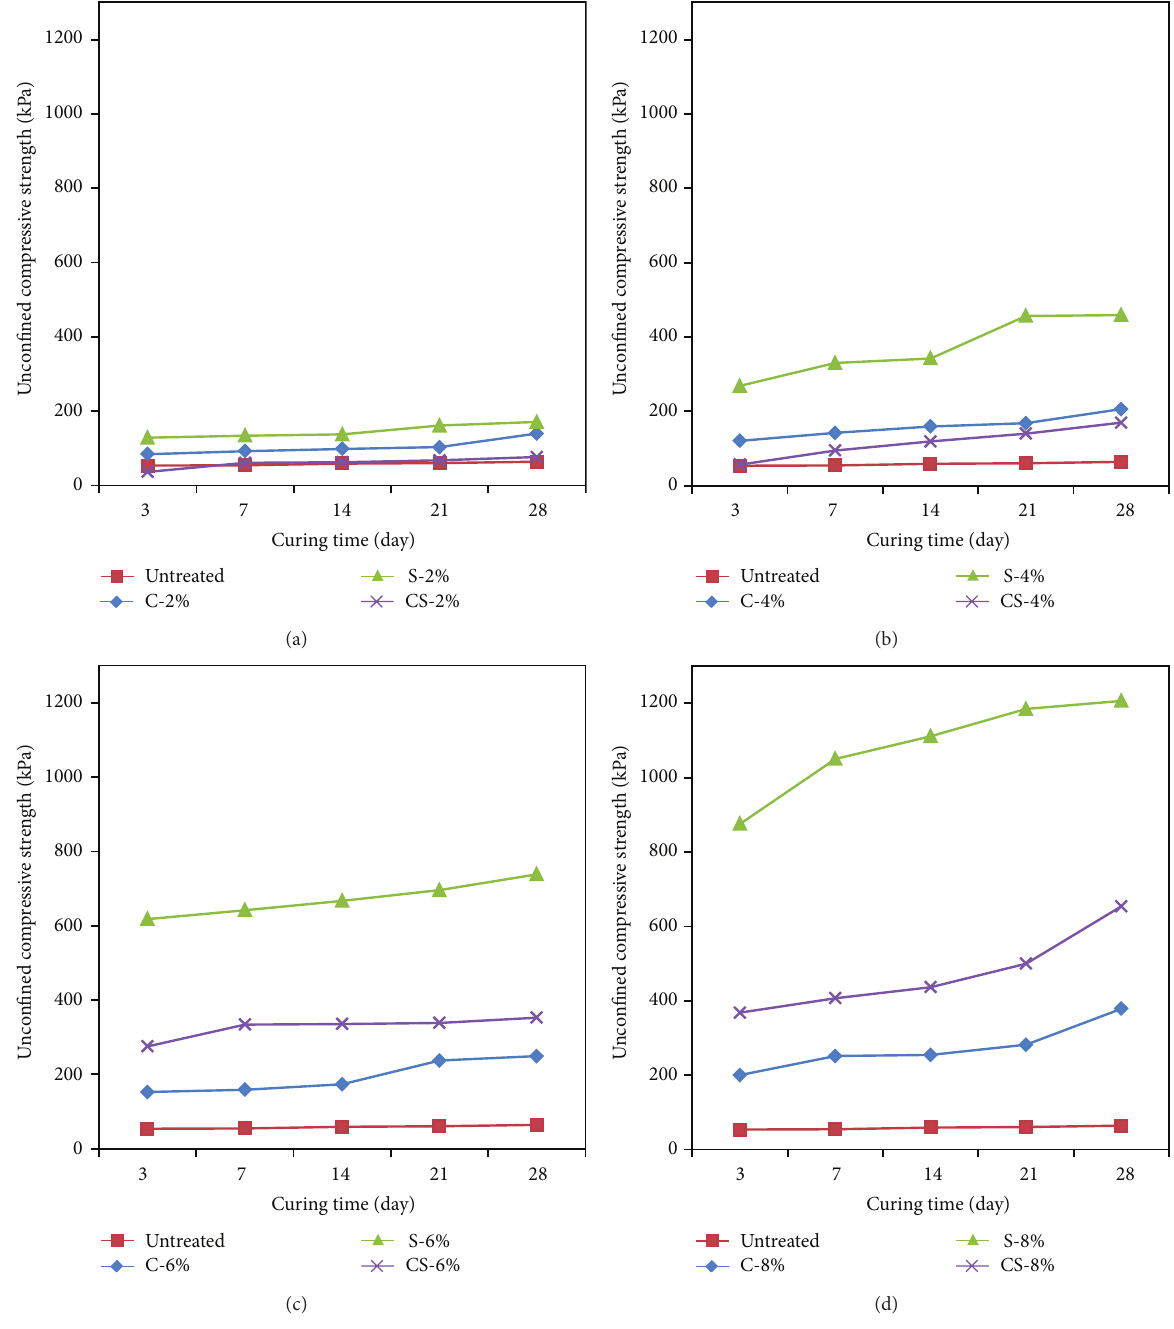
Figure 11: Strength of specimens by weight